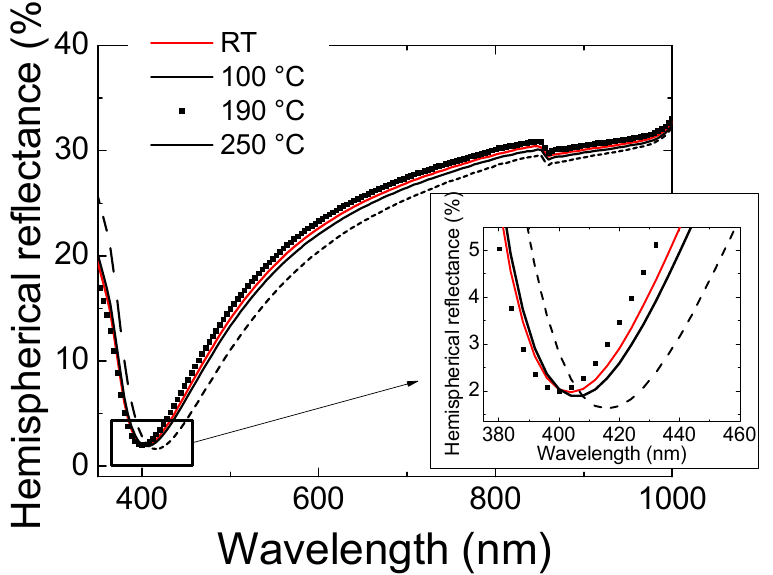
Figure 7. Hemispherical reflectance spectra of the photocells fabricated with ITO thin films deposited at different substrate temperature. In the inset, the zone in which the spectrum reaches a minimum.